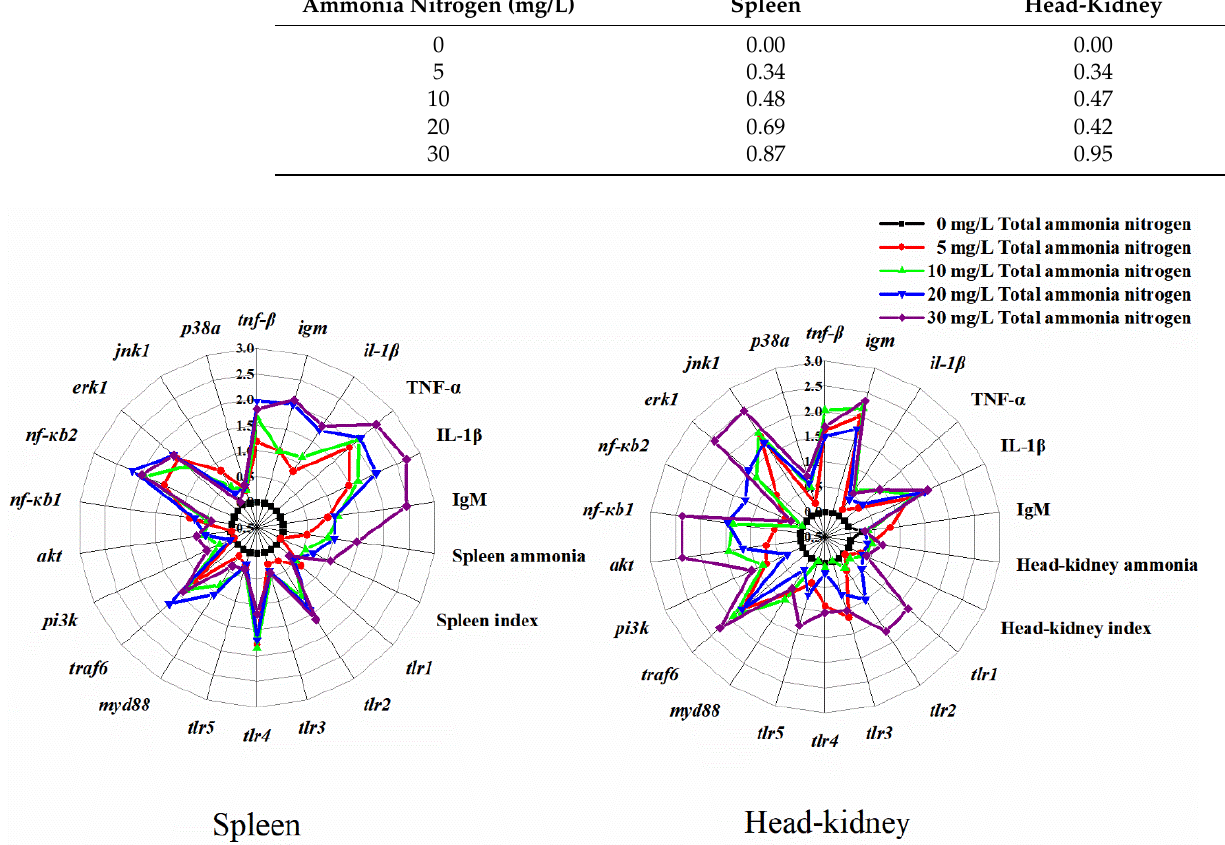
Figure 8. Star plots for biomarker responses in spleen and head-kidney in M. amblycephala exposed to ammonia